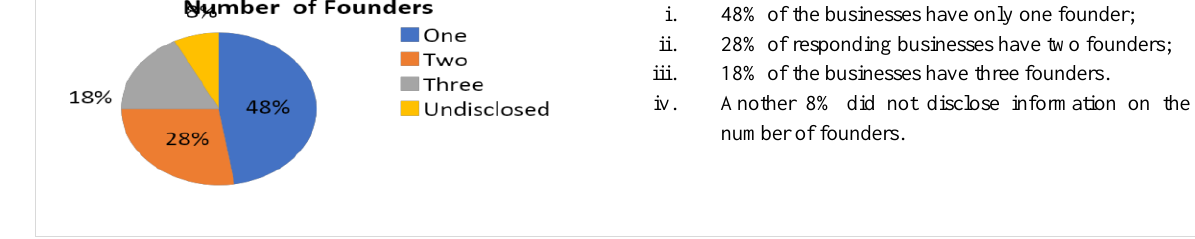
Figure 5: Number of Startup Founders